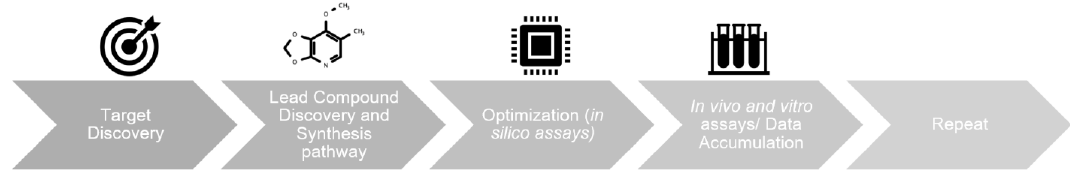
Figure 1. The general steps in drug discovery. Machine learning (ML) and deep learning (DL) algorithms may participate in each of the four steps listed, e.g., by mining proteomic in target discovery, discovering small molecules as candidates in lead discovery, developing quantitative structure-activity relationship models to optimize lead structures for improved bioactivity, and analyzing massive assay results.